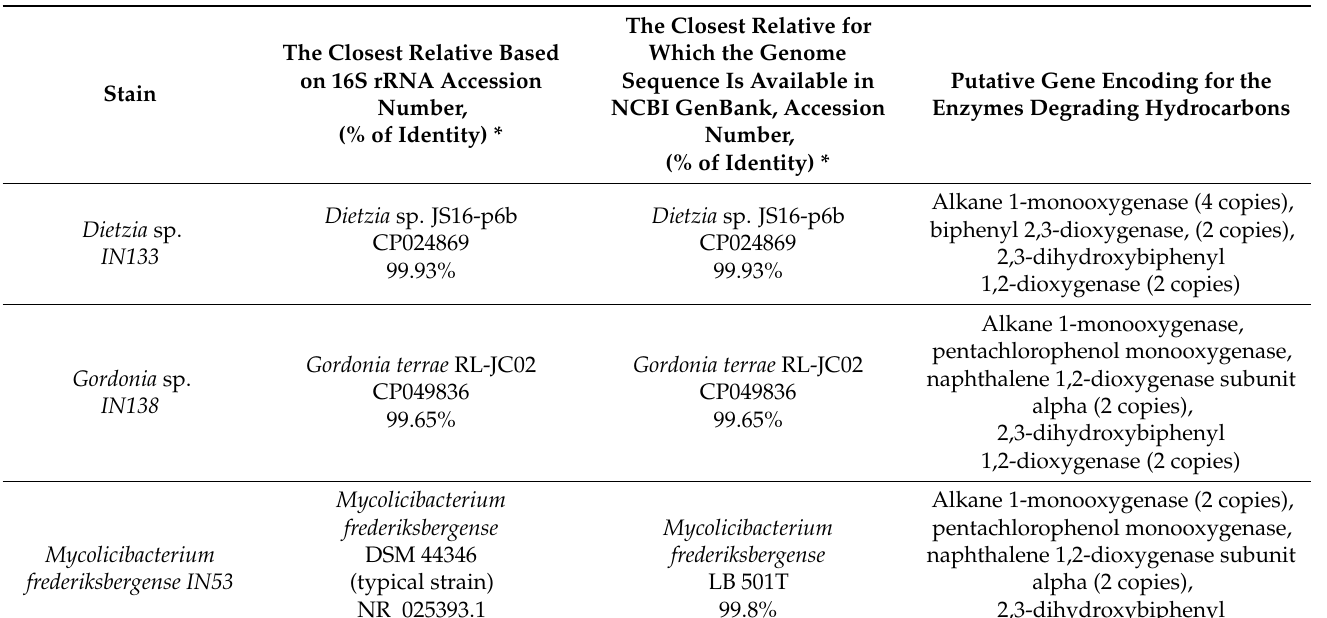
Table 1. Genes involve in petroleum hydrocarbon degradation, found in genomes for the closest relatives of all